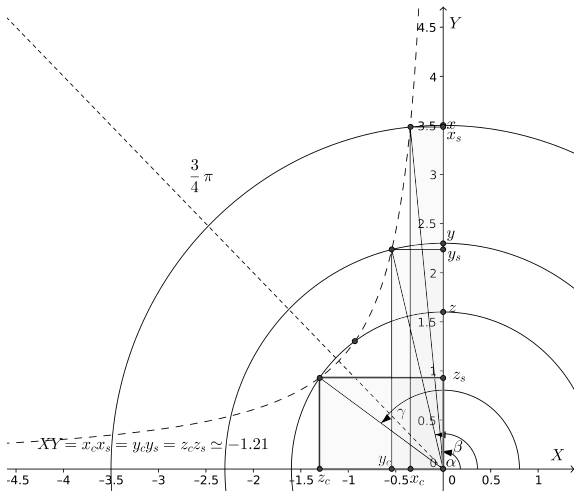
Figure 1: The corresponding α , β and γ for θ “ 6. , x “ 3.5 , y “ 2.3 and z “ 1.6